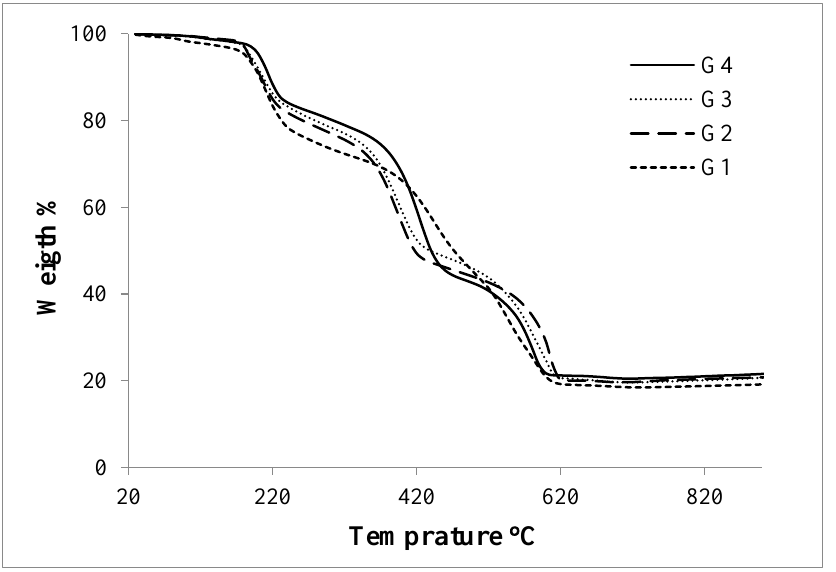
Figure 4. Thermogravimetric analysis (TGA) of G1-D3-Asp, G2-D6-Asp, G3-D9-Asp, and G4-D12-Asp.